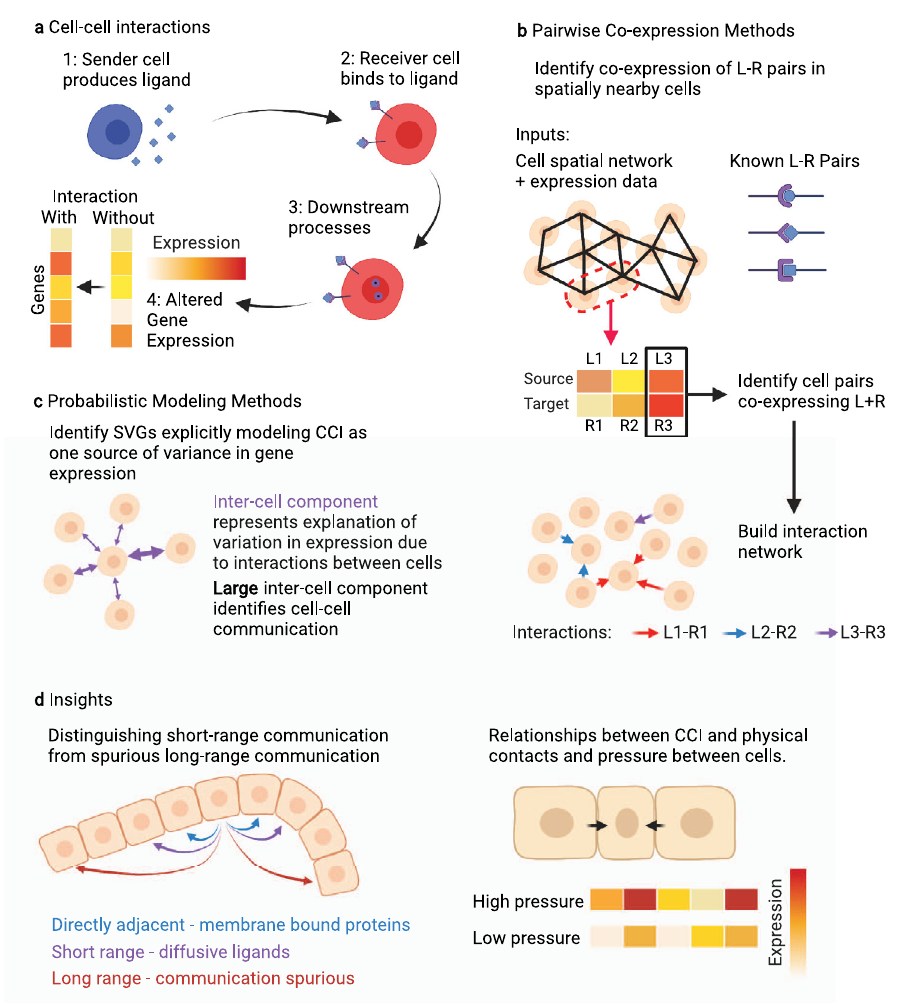
Fig. 3 Illustration of techniques in extracting cell-cell interactions from ST data. a Cell-cell interactions occur when transfer of a ligand from a sender cell to a receiver cell triggers a downstream response, ultimately leading to changes in gene expression in the receiver cell. b Common techniques identify co- expression of known L-R pairs in cells adjacent in a spatial proximity network, and use this to mark interactions between cells. c Alternatively, some methods probabilistically capture different sources explaining variance in spatial gene expression, including terms capturing intra- and inter-cellular effects. When inter-cellular effects dominate a particular gene ’ s expression, it is indicative of cell-cell interaction. d Insights made from CCI analysis of spatial data include the ability to determine interactions of a particular cell by fi ltering out spurious long-range connections, and investigations into the relationship between L-R interactions, and mechanistic interactions and cell